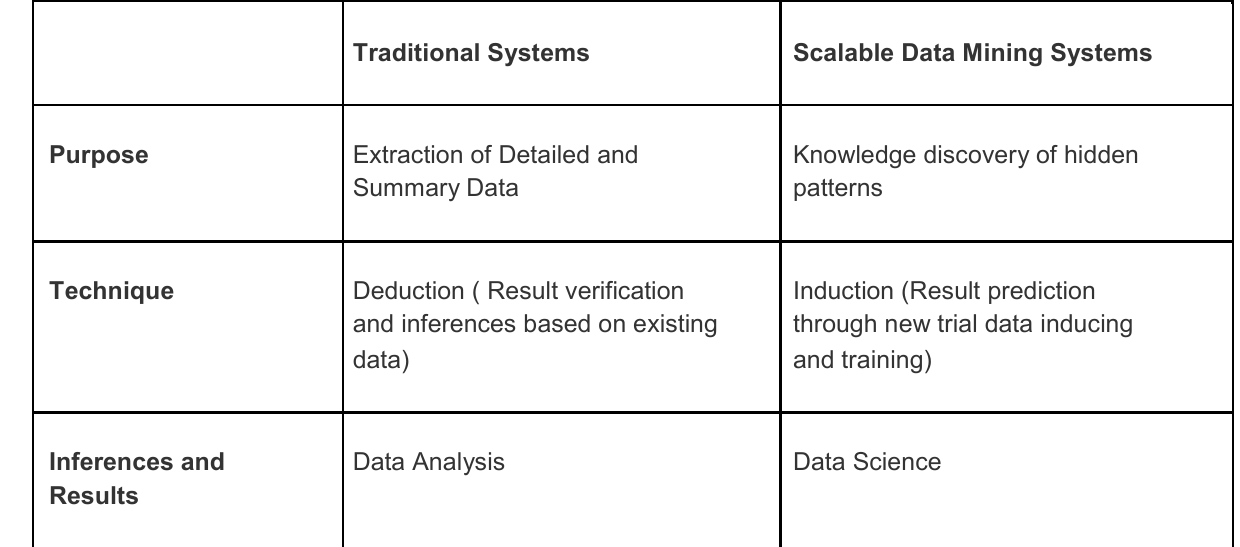
Table 1: Data mining